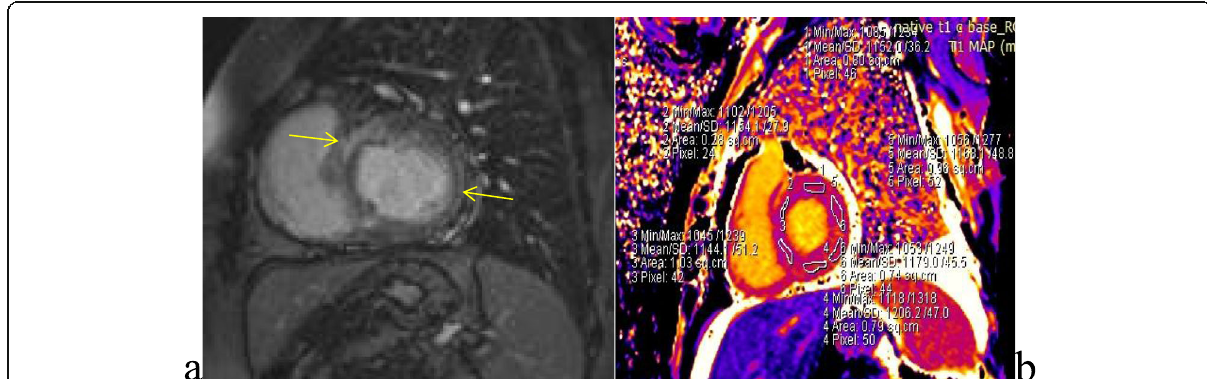
Fig. 3 Fifty-three-year-old female with progressive signs of left heart failure and infiltrative heart disease suspected at echo underwent MRI for further evaluation. a LGE was found global sub-epicardial enhancement in the anterior, inferior, and interventricular septum (arrow). b Non- contrast-enhanced T1 mapping shows that the native T1 value of the septal region including LGE is 1140 ms